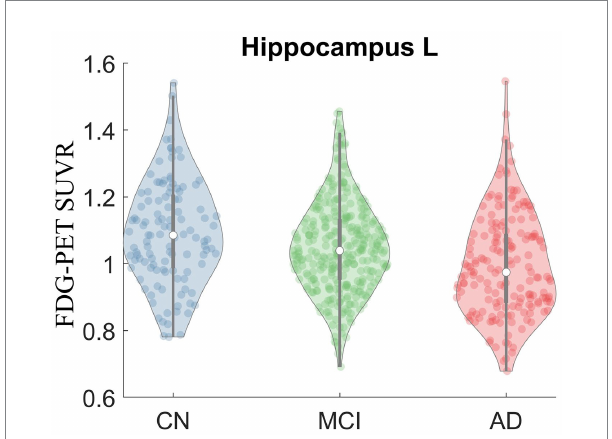
FIGURE 2 Violin plot of FDG-PET SUVR in CN, MCI and AD at left hippocampus. Significant group difference was identified in Kruskal-Wallis test ( p = 2.17E-7).